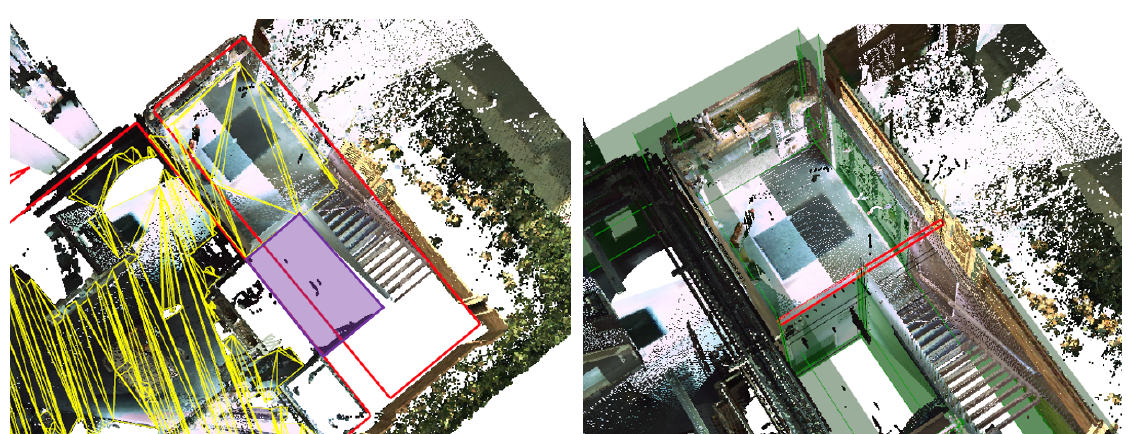
Figure 6: Overview partial room detection and wall topology: Failed room detection in purple due to absence floors and ceilings (left) and overextended wall in red that was rejected by room information